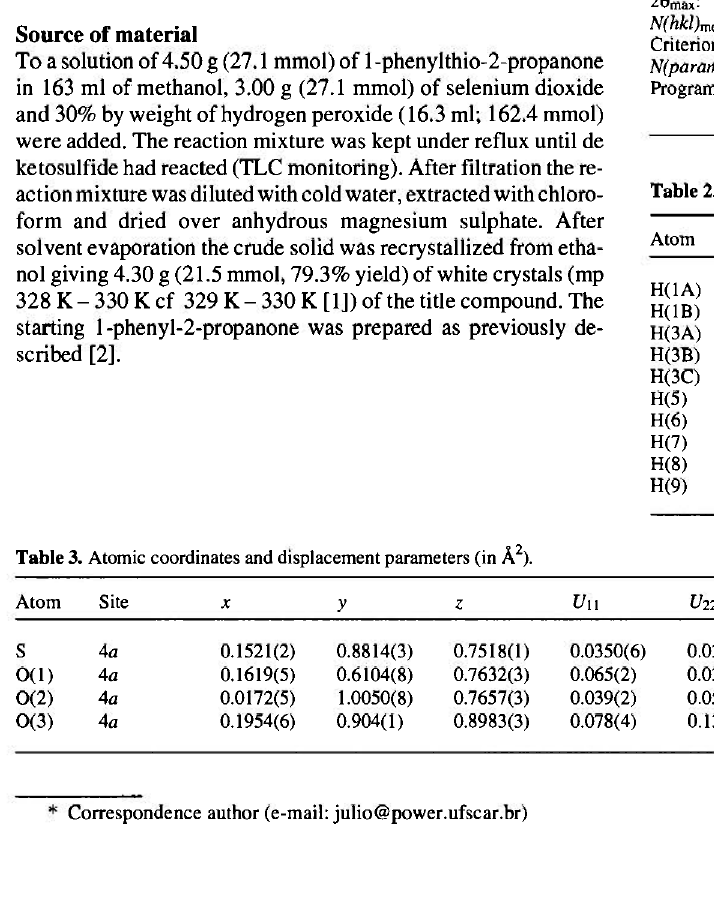
Table 1. Data collection and handling. Crystal: